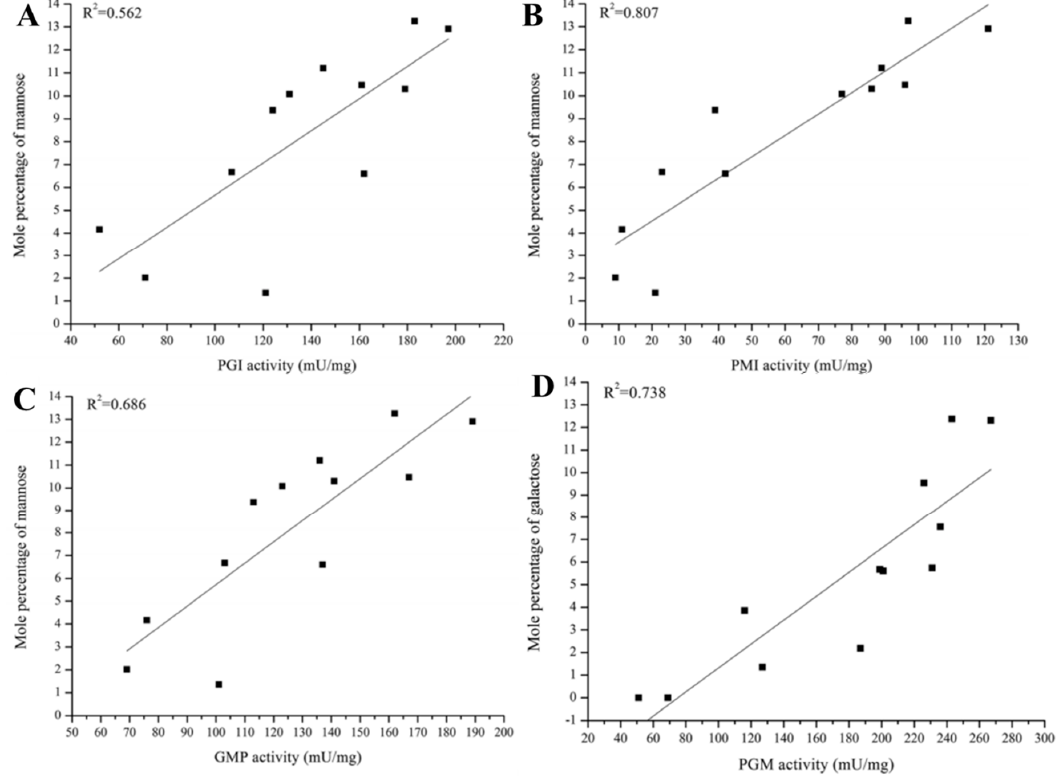
Figure 2. Correlations ( R 2 ) between activities of exopolysaccharide (EPS) synthesis enzymes and monosaccharide mole percentages under various carbon source conditions. ( A ) Phosphoglucose isomerase (PGI) and Man; ( B ) Phosphomannose isomerase (PMI) and Man; ( C ) GDP-Man pyrophosphorylase (GMP) and Man; ( D ) Phosphoglucose mutase (PGM) and Gal.